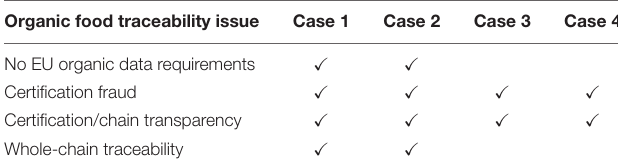
Frontiers in Blockchain |